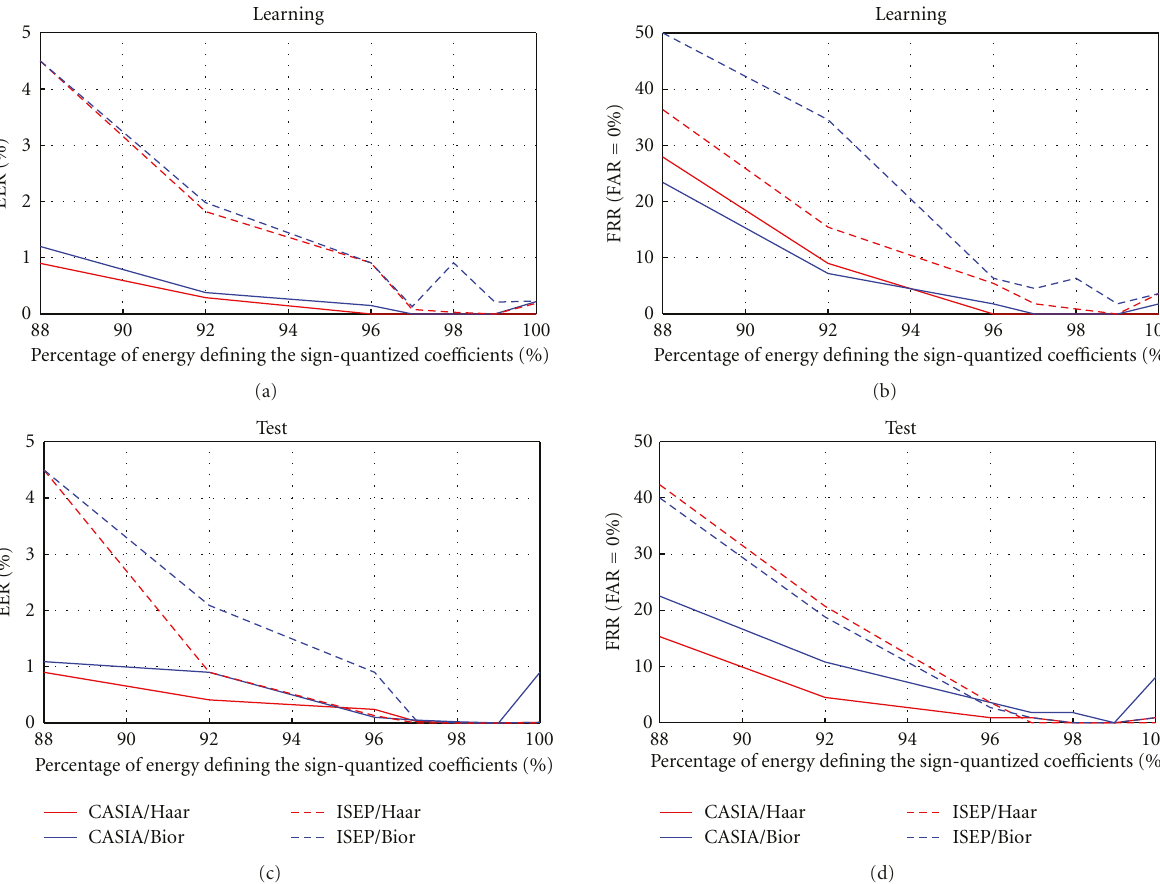
Figure 12: Performance results obtained for the choice of the wavelet and the percentage of energy defining the sign-quantized coe ffi cients. (a) EER and (b) FRR obtained on the training sets; (c) EER and (d) FRR obtained on the test sets.